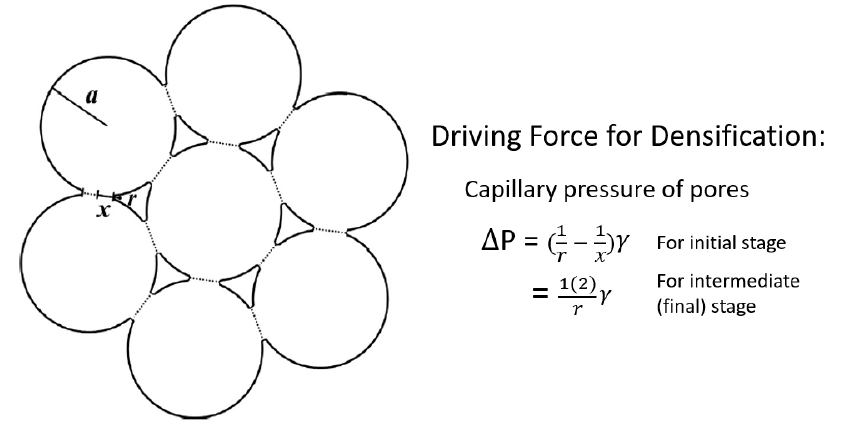
Figure 1. Idealized geometry of a powder compact to illustrate capillary pressure, ∆ P, for densification in sintering models [2] (reprinted with permission from Wiley). a : radius of the particle; x : radius of the neck between two particles; r : radius of curvature of the neck (pore); and γ : surface energy.